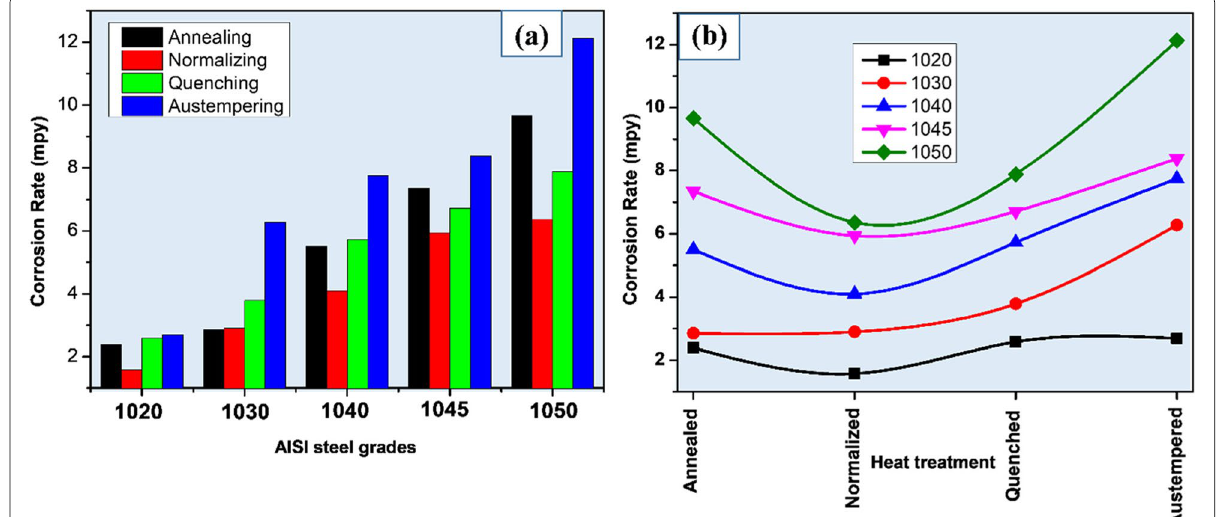
Fig. 8 Graphical representation of a carbon doping effect and, b Heat treatment effect on corrosion rate of different AISI steel samples after electrochemical testing in 3.5% NaCl